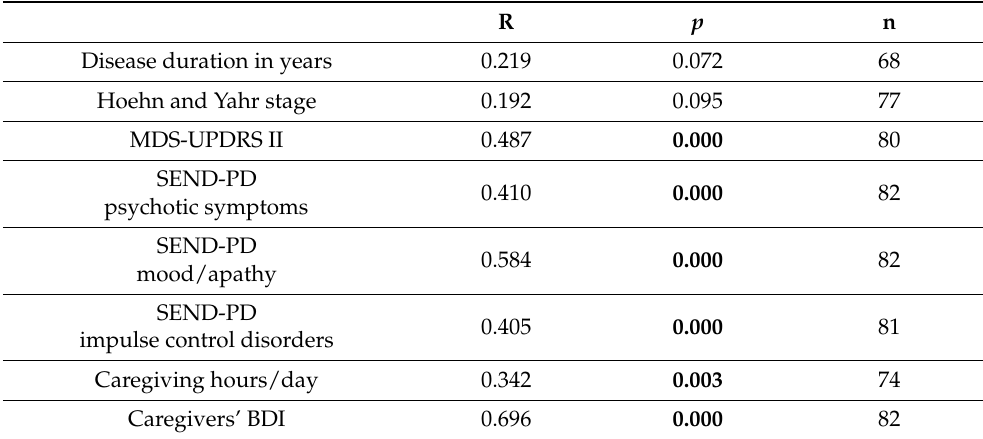
74 0.696 0.000 82 Spearman correlation of disease-related factors and caregiver burden (PDCB). p value adjustment for multiple comparisons was 0.05/8 = 0.006. Significance level at p < 0.006 is printed in bold . BDI, Beck’s Depression Inventory, MDS-UPDRS II, Movement Disorder Society unified Parkinson’s disease rating scale; n; number of included caregivers; SEND-PD, Scale for evaluation of neuropsychiatric disorders in Parkinson’s